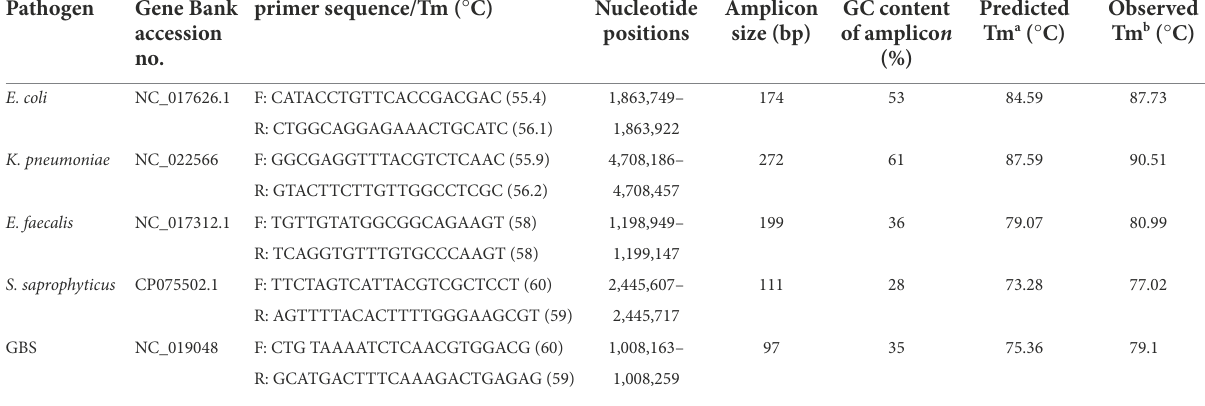
TABLE 1 List of primers used in this study and its